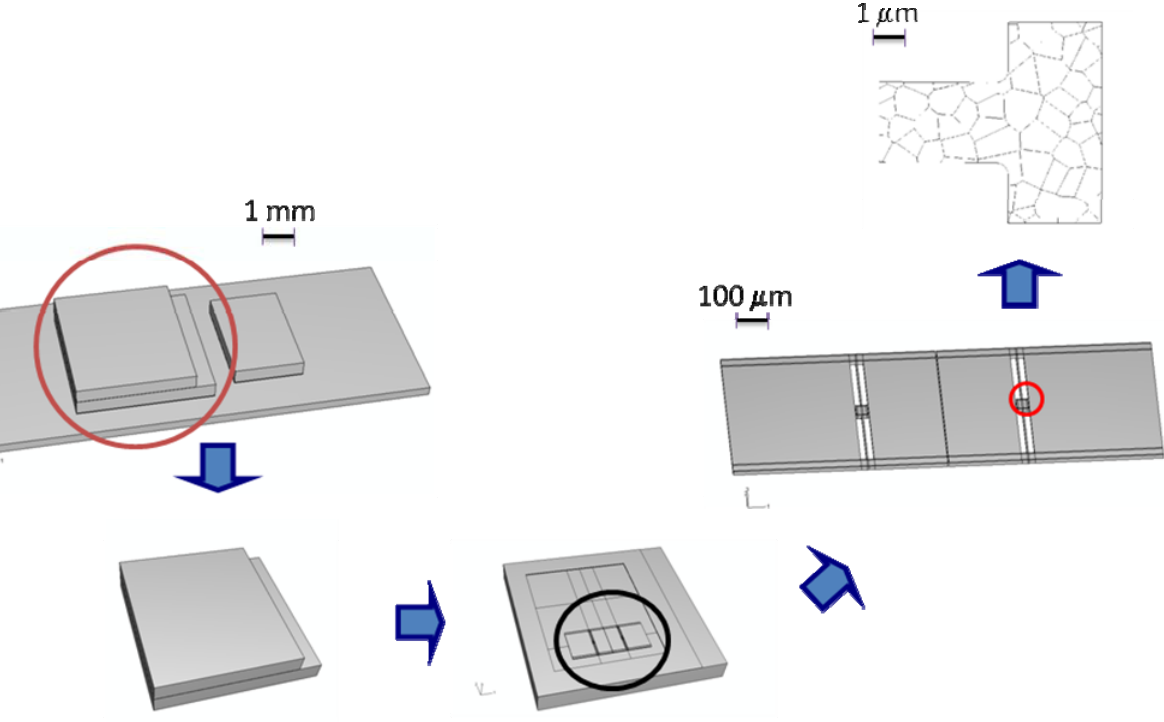
Figure 2. Length scales and domains involved in failure modeling, ranging from macro- scale at the package level down to micro-scale at the polycrystal